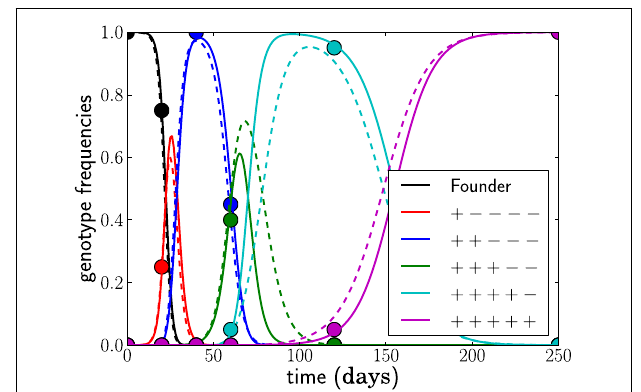
FIGURE 3 |The deterministic model parameterized by seed times τ j for the L dominant genotypes and the escape rates of epitopes ε i (solid lines) captures the dynamics of the stochastic model accurately (dashed lines) .The trajectories (and seed times) vary from run to run. In this run, N = 10 7 , µ = 10 − 5 , and r = 0 and the escape rates are ε j = 0.5, 0.4, 0.25, 0.15, 0.08 per